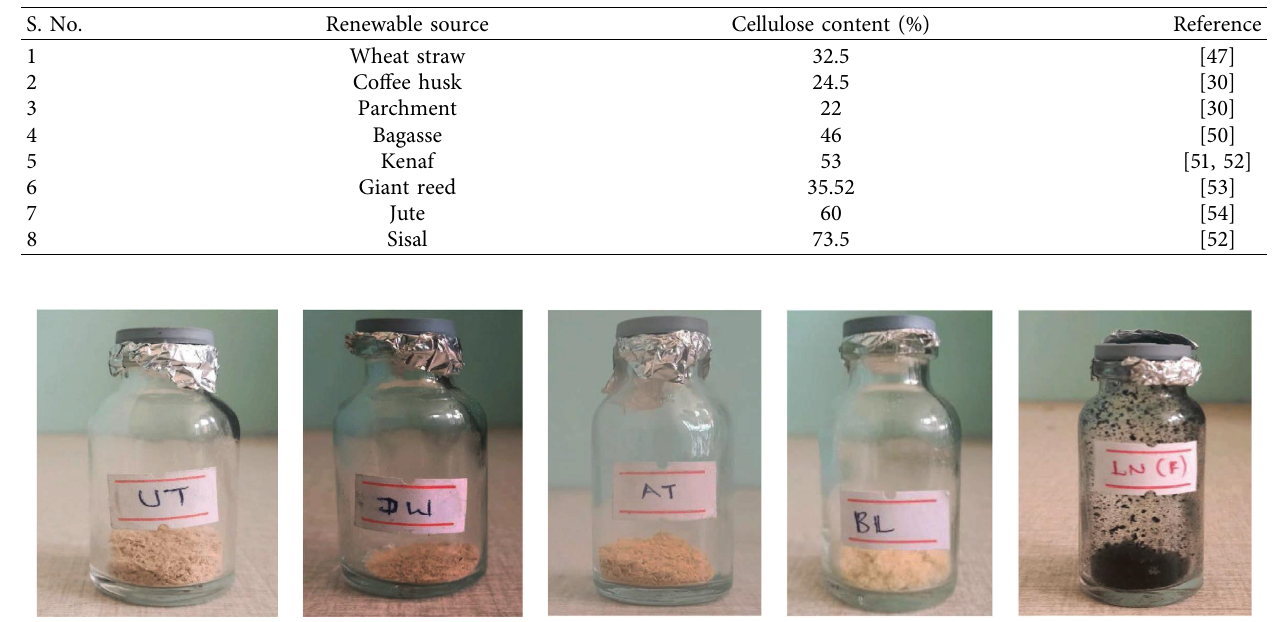
Table 2: Cellulose obtained from diferent renewable